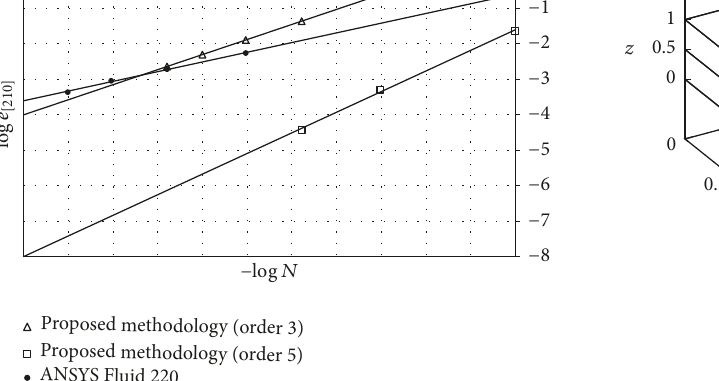
̂𝜆 1/𝑁 ( ℎ -convergence). 210 versus